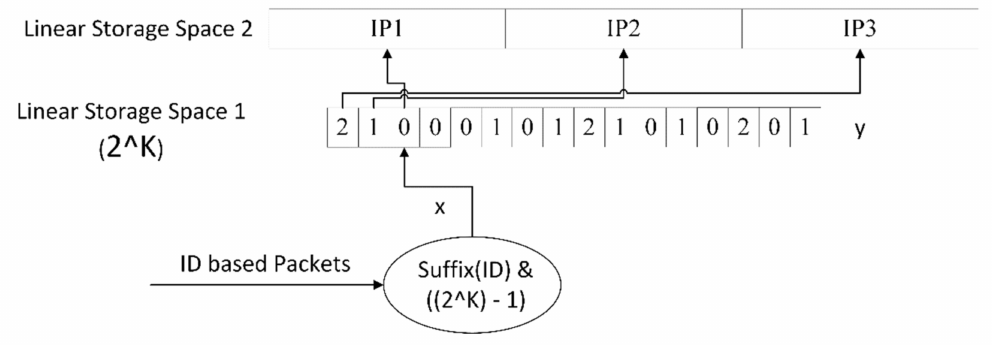
Figure 5. The load balancing strategy